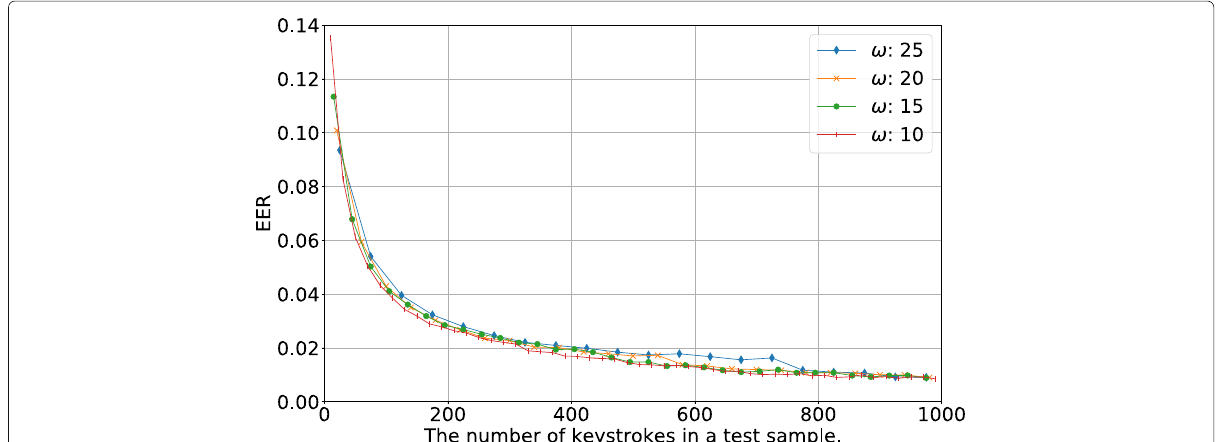
Fig. 4 The relationship between EER and the number of keystrokes in a